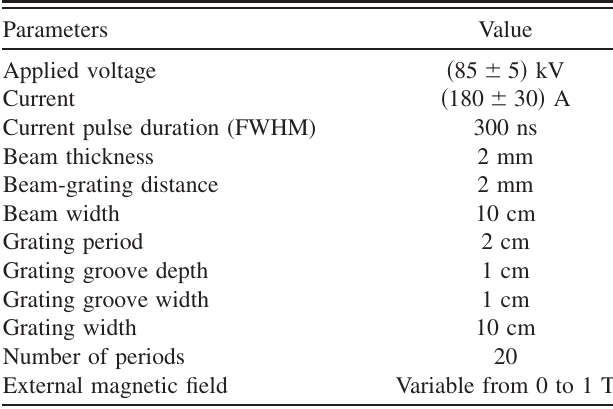
TABLE I. Experimental parameters.